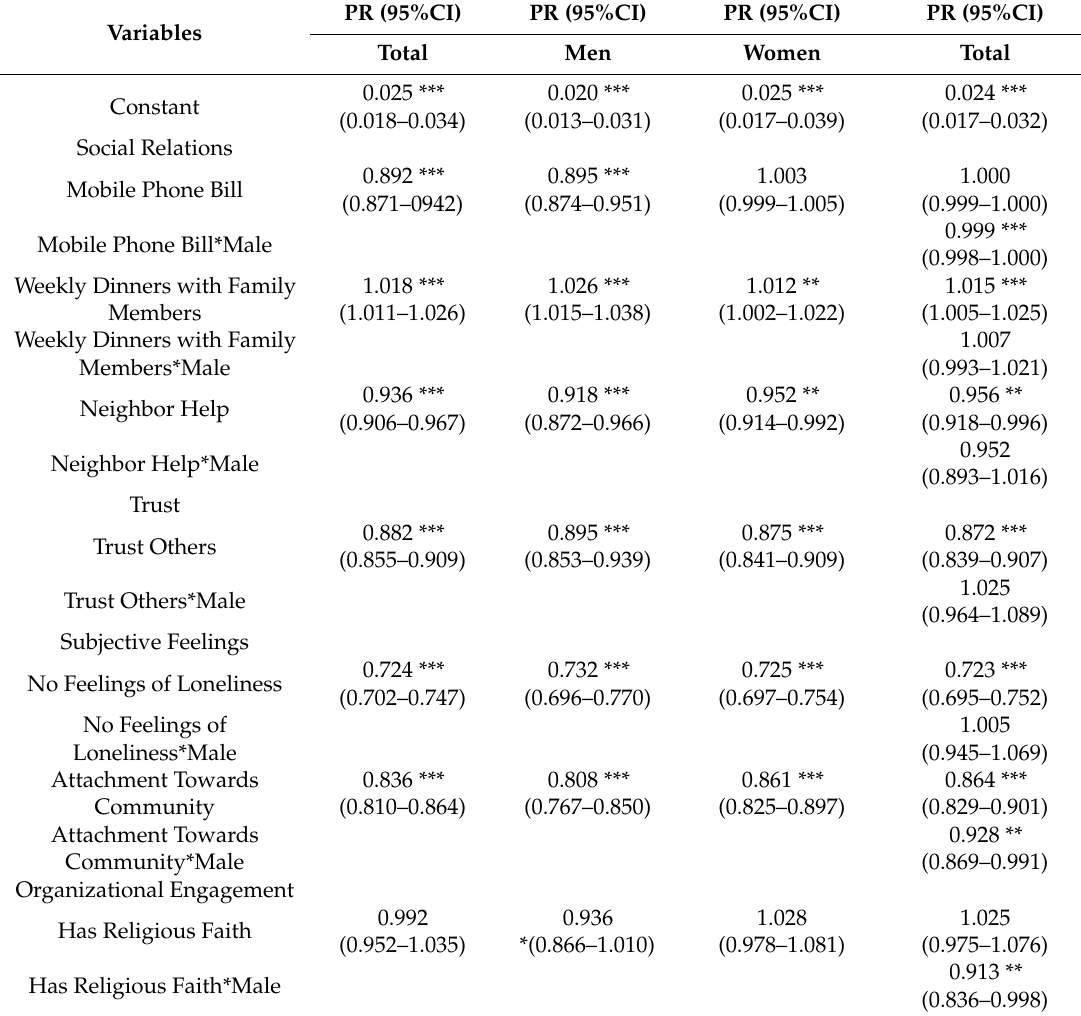
Table 2. Prevalence of reporting fair and poor health values for the whole sample, and for women and men